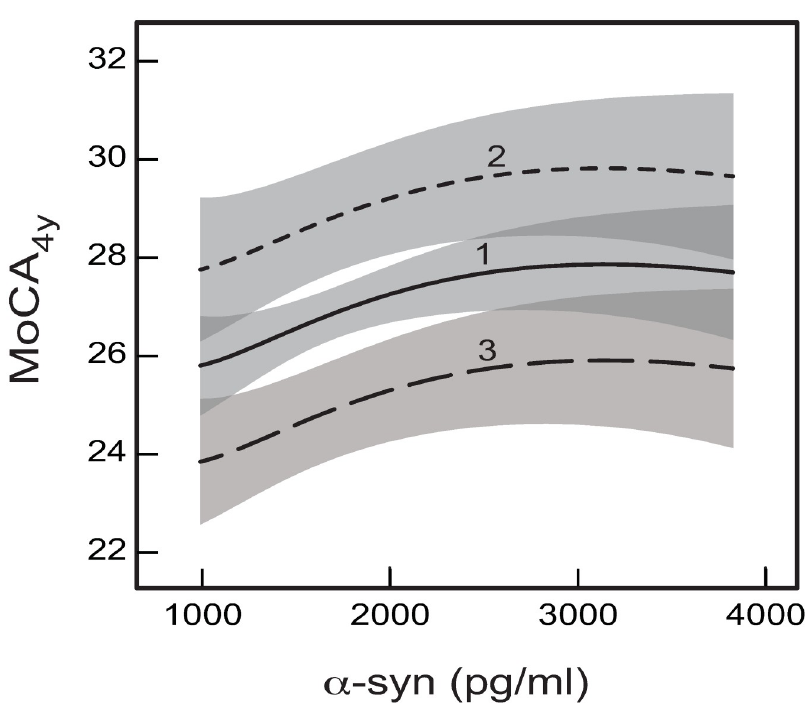
Fig 4. The predicted dependences of MoCA 4y on baseline CSF concentration of α -syn. The dependences result from the direct effects on MoCA 4y in the GSEM network given by Fig 1A for the following baseline ages: (1) Age = 60 years; (2) Age = 40 years; (3) Age = 80 years. The shaded bands indicate the 95% prediction intervals for the respective curves. The darker shade areas indicate overlaps of the prediction intervals for the neighboring curves. The other measures having direct effects on MoCA 4y were taken at their mean values: MoCA b = 27, UPDRS 1-3 = 31.87, GDS = 2.30, average ln(t-tau) = 3.71 (t-tau = 40.85 pg/ml), and average (A β 1–42 ) 1/2 = 18.95 (A β 1–42 = 359.10 pg/ml).